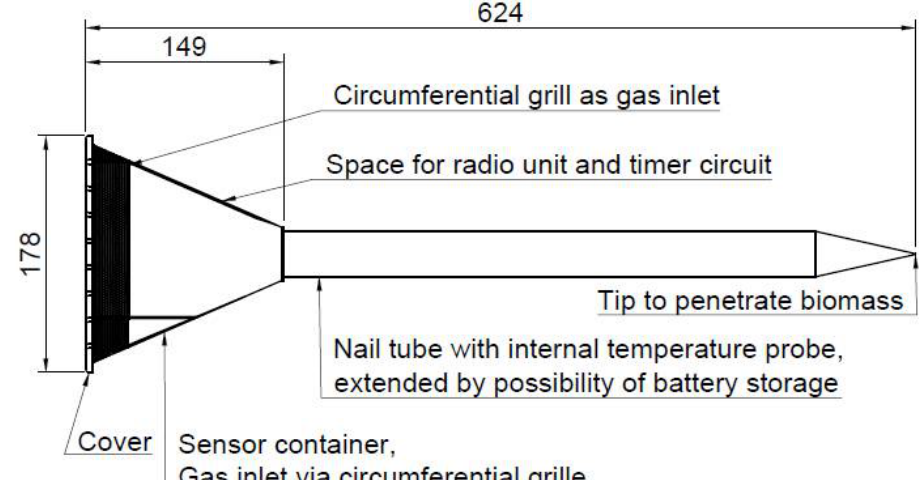
Figure 3. Schematic of the first-generation sensor node (drawn with Autodesk Fusion). After the initial small-scale silage test, a circumferential grill was applied and the gas entry was enlarged. Sizes are shown in mm.